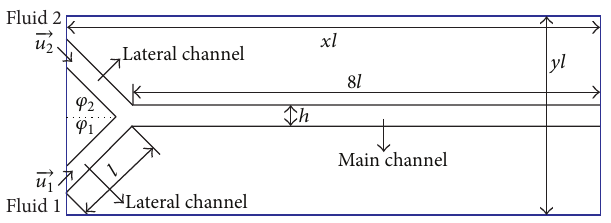
Figure 1: Computational model